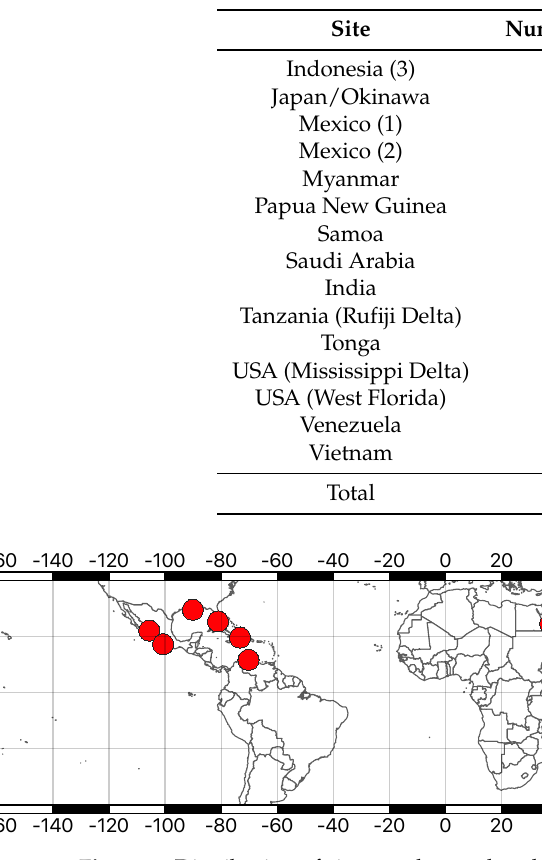
Figure 3. Distribution of sites used to undertake the accuracy assessment.